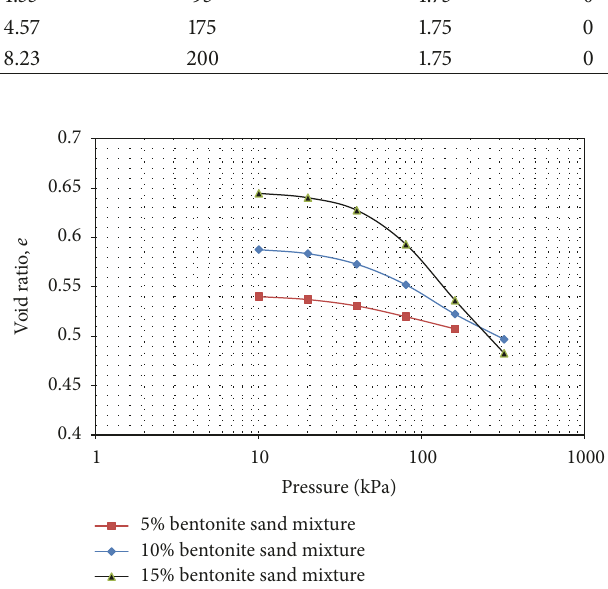
Figure 4: Void ratio versus log pressure curves for sand-bentonite mixtures.